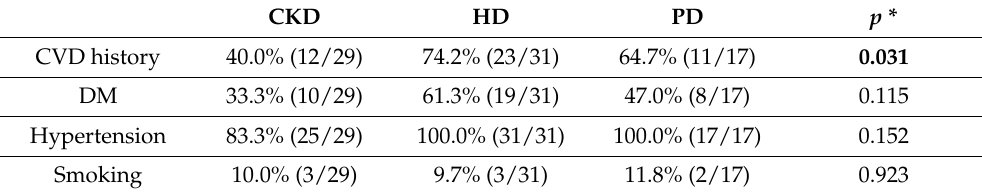
Table 1. The characteristics of the studied groups of men including comorbidities.